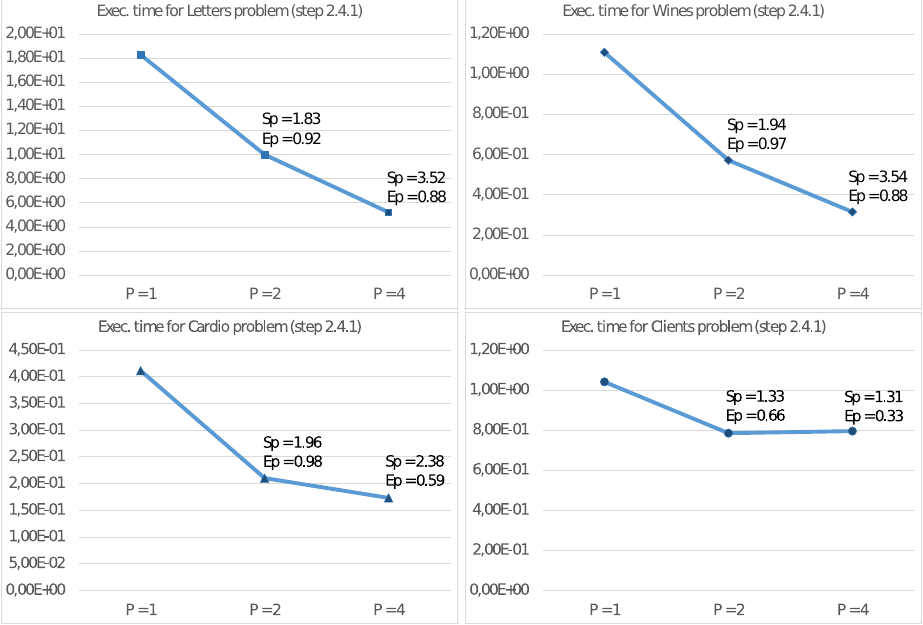
Figure 4. Execution time (in seconds), Speed-up and Efficiency of step 2.4.1 Algorithm 2 on the UDOO X86 Advanced+